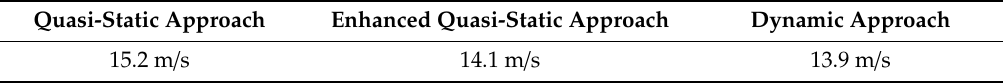
Figure 17. Vertical reaction force of windward tire of each trailer model. Table 2. Determined critical wind speed for the overturning accident of the trailer.